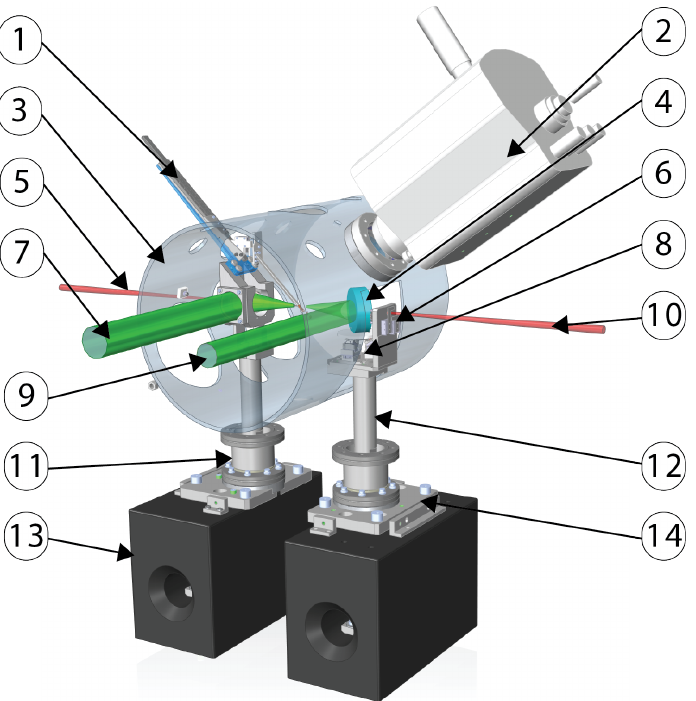
Figure 5. The DREAM optical laser setup; indicated are the sample and focus diagnostic paddle (1), the long-range microscope (2), the main chamber body (3), the off-axis focus mirror for the optical laser (4), the X-ray out towards the diagnostic (5), the X-ray scatter slits (6), the optical laser out towards the optical laser diagnostic (7), the in-vacuum hexapod for the alignment of the optical laser focus (8), the optical laser in towards the focus spot (9), the X-ray incoming from the FEL (10), the vacuum extension of the main chamber for the laser posts, which are decoupled from the vacuum chamber (11), the optical laser infrastructure post (12), the support granite (13), and the out-of-vacuum laser support and alignment structure